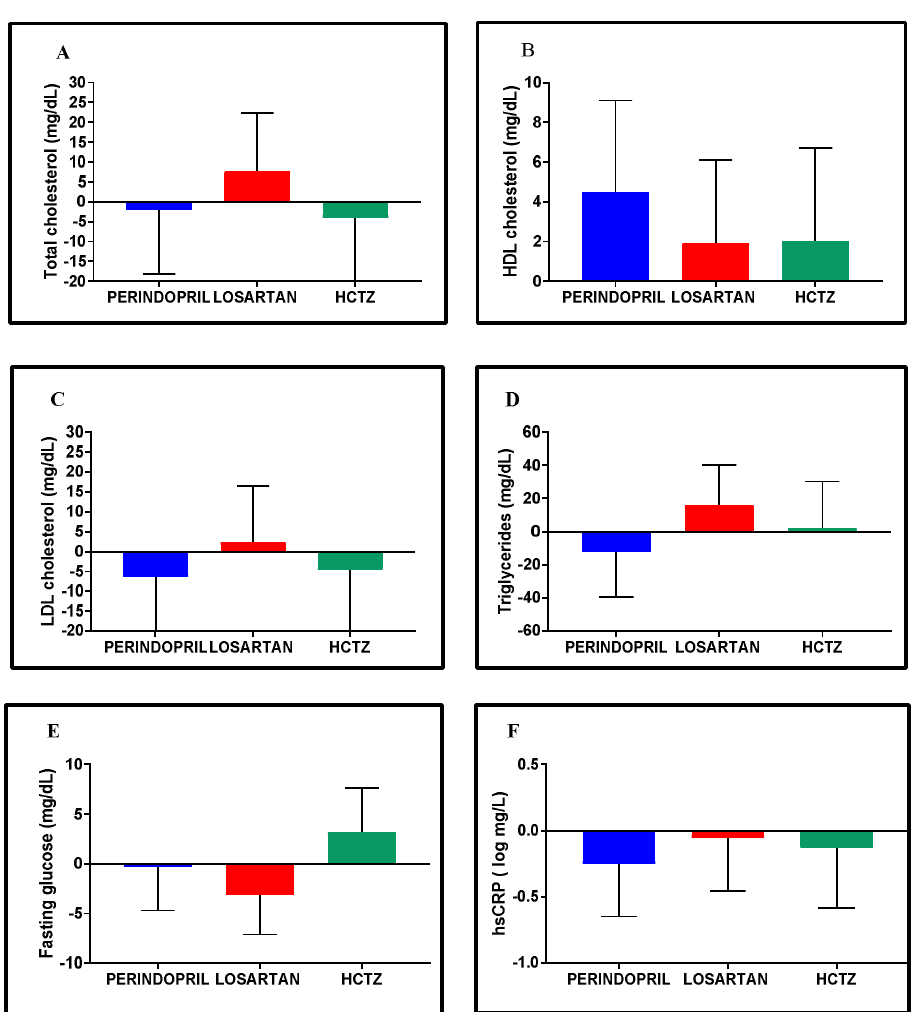
Figure 5. Adjusted mean change within groups in lipid ( A–D ) and fasting glucose profiles ( E ) and in high-sensitivity C-reactive protein ( F ) from baseline to 24-week follow-up. Data are expressed as adjusted mean change within groups with 95% confidence intervals adjusted to age, sex, and baseline status. HDL cholesterol: High-density lipoprotein cholesterol; hsCRP: High-sensitivity C-reactive protein; LDL cholesterol: Low-density lipoprotein cholesterol. Log-transformation was used to normalize data distribution (Shapiro–Wilks test, p <